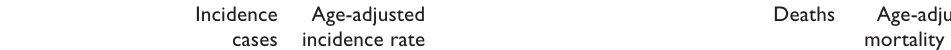
Table 1. Age-adjusted Cervical Cancer Incidence and Mortality Rates per 100,000 World Standard Population, 2008 Incidence Age-adjusted Deaths Age-adjusted cases incidence rate mortality Rate Top 25 countries with the highest mortality